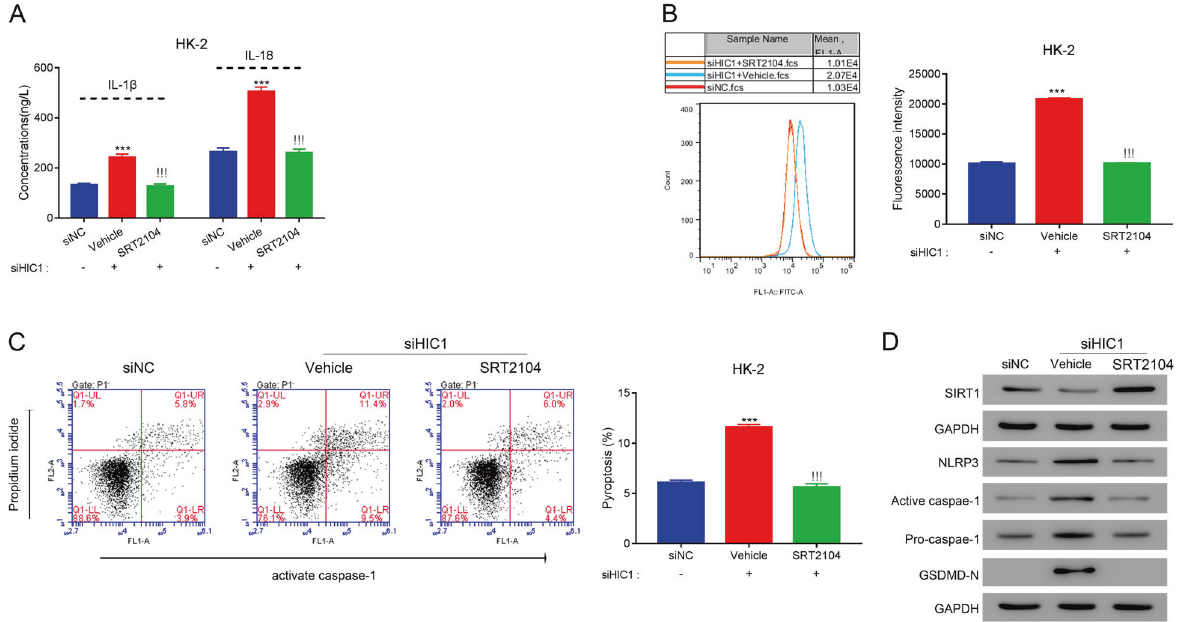
Fig. 9 HIC1 inhibits pyroptosis by reducing oxidative stress. HK-2 cells were transfected with control siRNA (siNC) or HIC1 siRNA (siHIC1), and the cells were treated with a vehicle or N-acetyl cysteine (NAC). A The secretions of IL-1 β and IL-18 were quanti fi ed using ELISA. B ROS levels were quanti fi ed using the DCFDA assay kit. C Pyroptosis was measured through quanti fi cation of cells with active caspase-1. D Expression of indicated proteins was measured with western blotting. *** P < 0.001 vs. siNC; !!! P < 0.001 vs. vehicle.